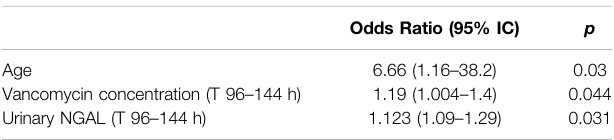
TABLE 4 | Logistic Regression associated with